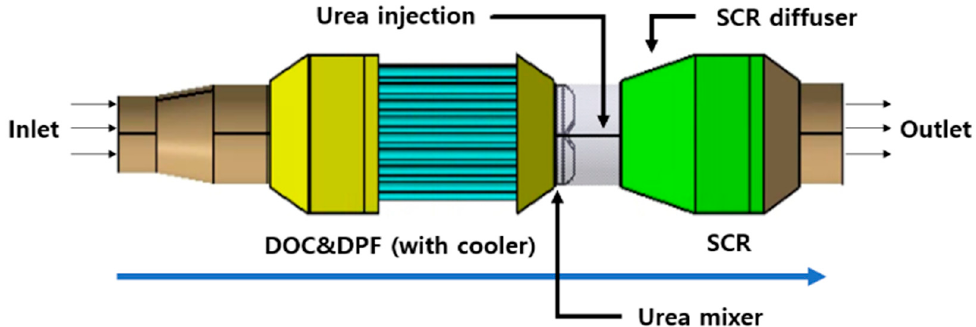
Figure 1. Configure of PM/NO X aftertreatment system for emergency generator. There is a mixing section (reactor) between the DPF and the SCR, and a urea injection nozzle is installed at the point 2/3 of the reactor. The front end of the reactor is equipped with an eight-blade mixer with a diameter of 150 mm for urea mixing, shown in Figure 2.